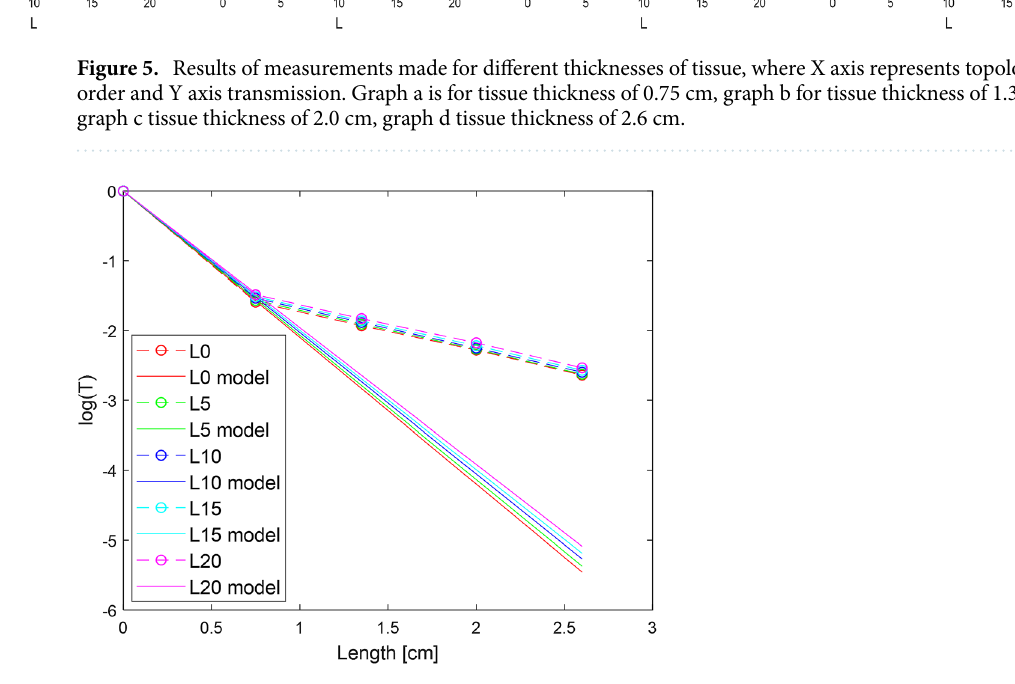
Figure 6. Transmission as a function of length; each line represents a different topological order of the beam. The solid lines represent the modeled transmission function, the dotted lines represent the measured values, one line for each topological order. The discrepancy between model and measured values is due to the fact that the model approximates transmission of ballistic photons only, and as thickness increases the number of snake photons increases as well.